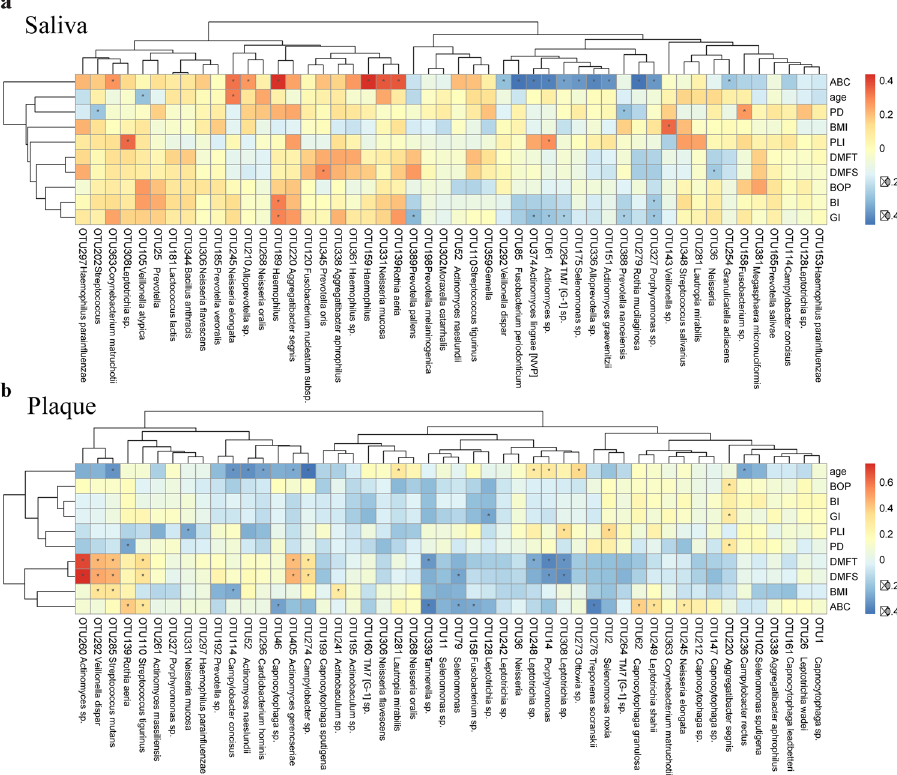
Figure 5. Correlation between OTUs and various clinical indices. The abundance of OTUs (top 50) enriched in saliva ( a ) and dental plaques ( b ) of ASD children and controls were analyzed for covariation with clinical variables using Spearman’s rank correlation. The correlation effect is indicated by a color gradient from blue (negative correlation) to red (positive correlation). Correlation coefficients and p-values ( * p < 0.05) are shown. OTUs and clinical variables in the heat maps were ordered using unsupervised hierarchical clustering. BMI, Body Mass Index; DMFT, Decayed-Missing-Filled Teeth; DMFS, Decayed-Missing-Filled Surface; PLI, Plaque Index; GI, Gingival Index; BI, Bleeding Index; PD, Probing Depth; BOP, Bleeding on Probing; ABC score, scale of ASD